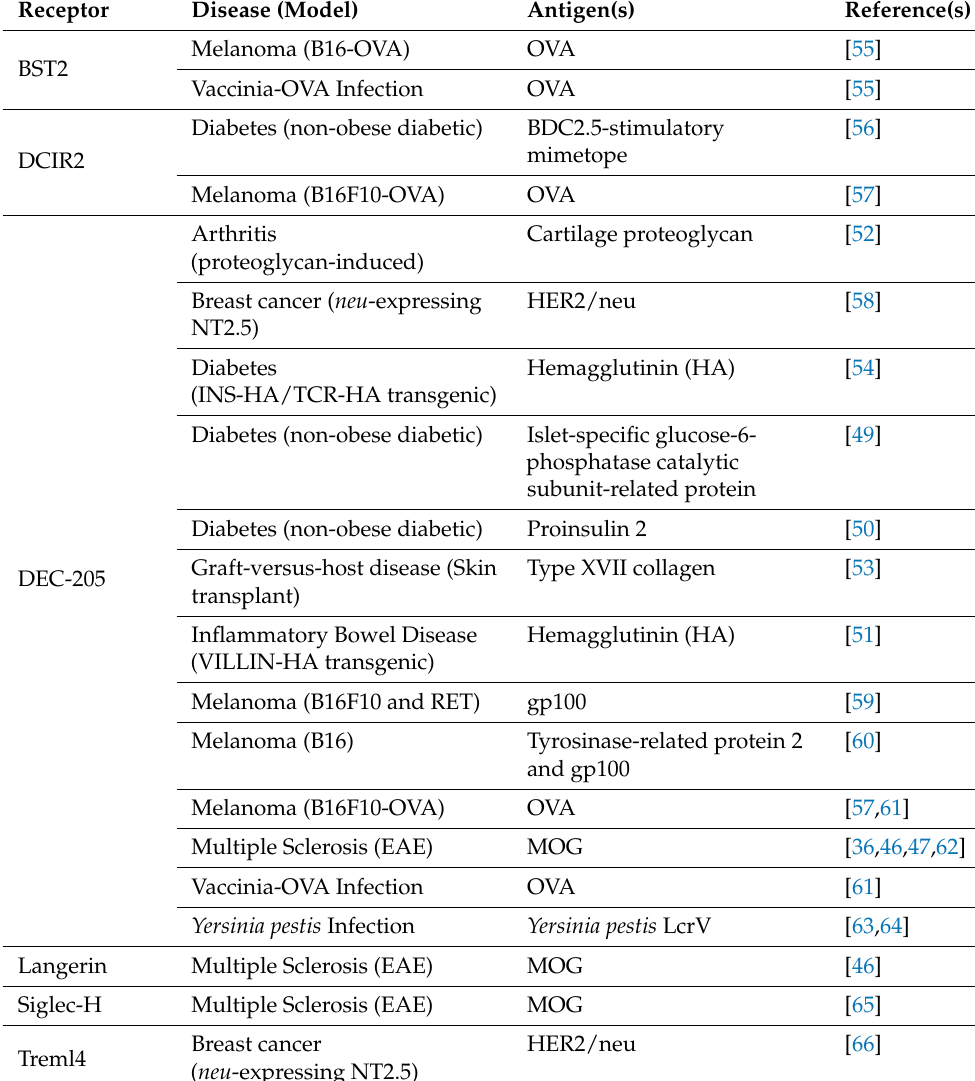
Table 1. Summary of the different DC surface receptors used for delivery of specific antigens in different disease